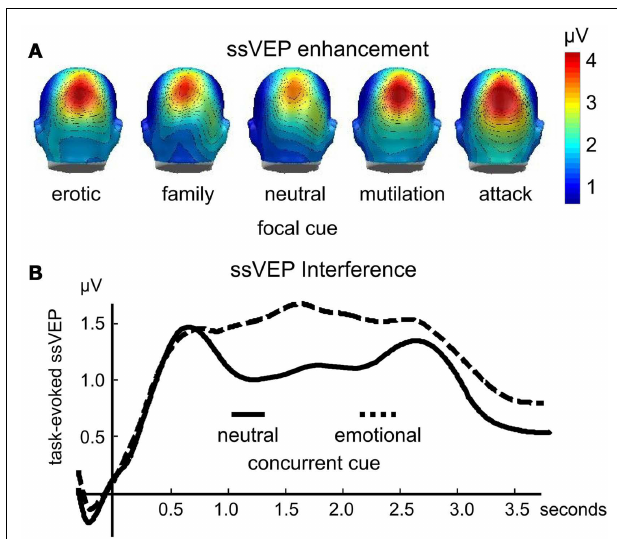
FIGURE 2 |The amplitude of the time varying steady-state visual evoked potential is enhanced when evoked by focal emotional, compared to neutral pictures [(A); redrawn from data in Keil et al., 2008]. Conversely (B) , the ssVEP is reduced when evoked by a focal task stimulus that competes with an emotionally engaging distractor (data from Wieser et al., 2012).This interference lasts between several hundreds of milliseconds and several seconds, depending on the complexity and strength of the distractor and the primary task (Müller et al.,